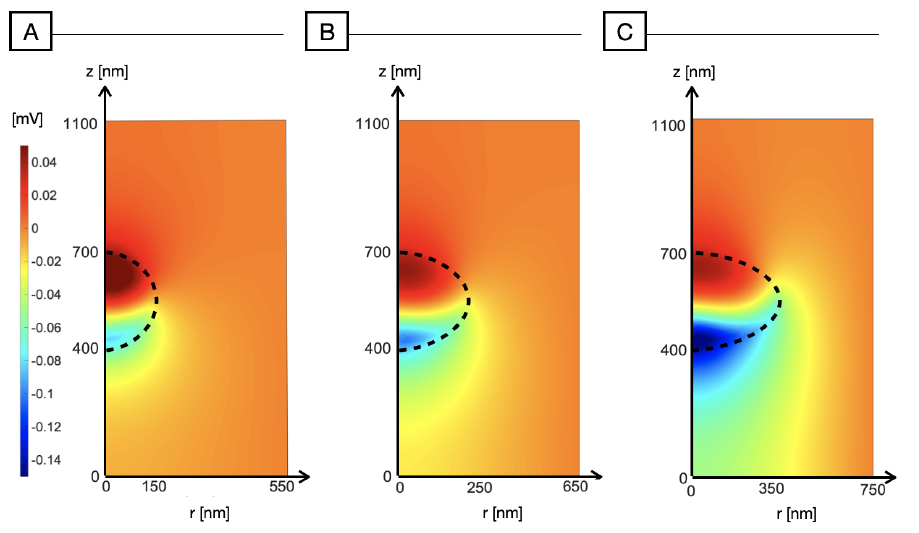
Figure 6. Electric potential distribution (mV) across the nanoparticle and the surrounding medium for increasing the ellipticity of the NP. To enhance ellipticity, we increase the radius r 1 perpendicular to the r − axis and to the light impinging direction, while the radius r 2 parallel to light is kept fixed at 150 nm. ( A ) r 1 = 150 nm, r 2 = 150 nm; ( B ) r 1 = 250 nm, r 2 = 150 nm; ( C ) r 1 = 350 nm, r 2 = 150